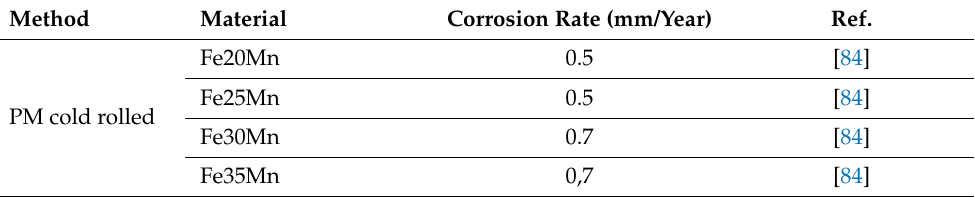
Table 8. Corrosion rates for Fe-based materials obtained by powder metallurgy followed by cold rolling.